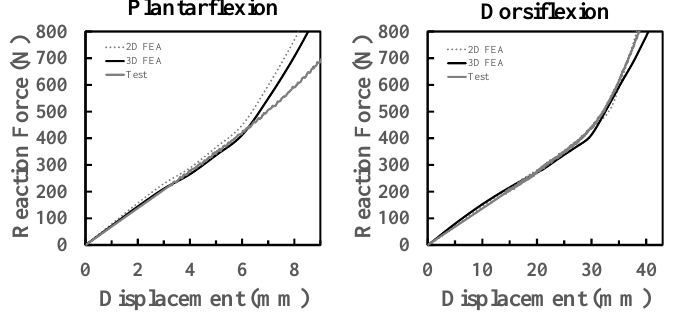
Figure 25. Comparisons among the static plantarflexion and dorsiflexion 2D FEAs and 3D FEAs and the mechanical tests on the physical prototype with stiffness curves given as reaction force–displacement